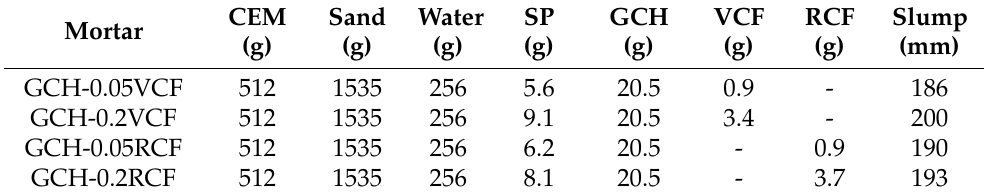
Table 2. Mix design of mortars and slump value—the second part of the